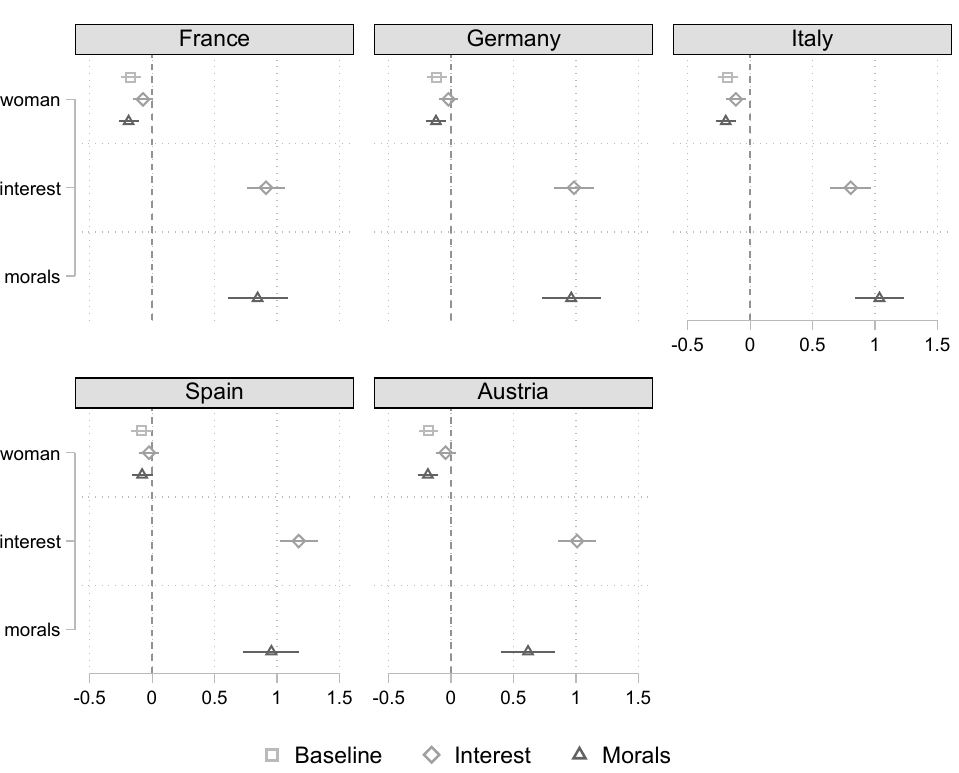
Figure 1. Alternative models to explain the gender gap regarding the duty to vote (CEESP).